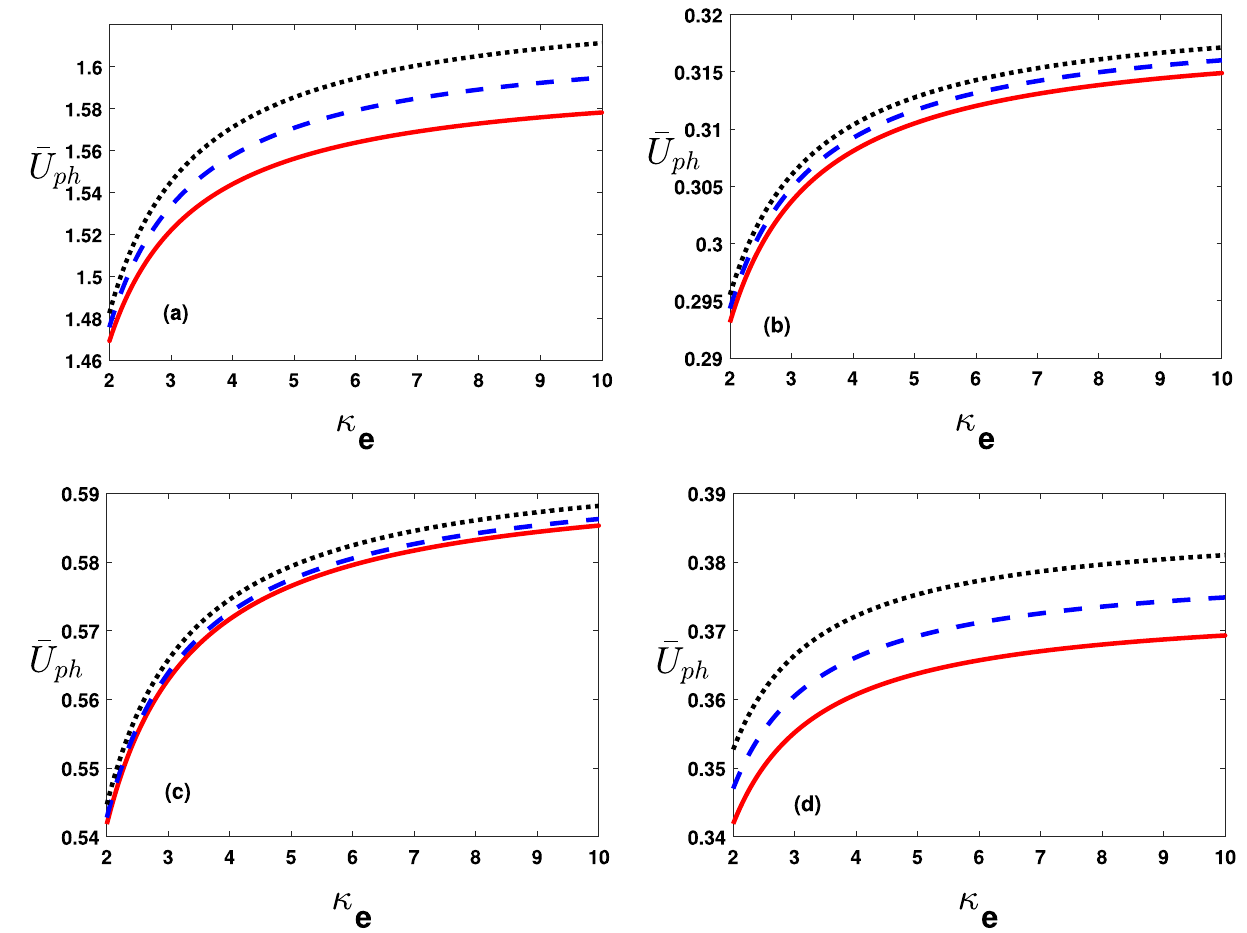
10 7 cm s − 1 ) varying with κ e from 2 to 10 by changing ( a ) = 10 3 K (dashed curve) and 1.2 10 3 K (dotted 10 3 K (solid curve), 1.1 × × = 10 3 K (solid curve), 1.01 10 3 K (dashed curve) and = × 10 5 cm s − 1 (solid curve), 1.2 10 5 cm s − 1 (dashed curve) = × 0.6 (solid curve), 0.609 (dashed curve) K z / K 0 ) K z ( K z values as ¯ ¯ = =